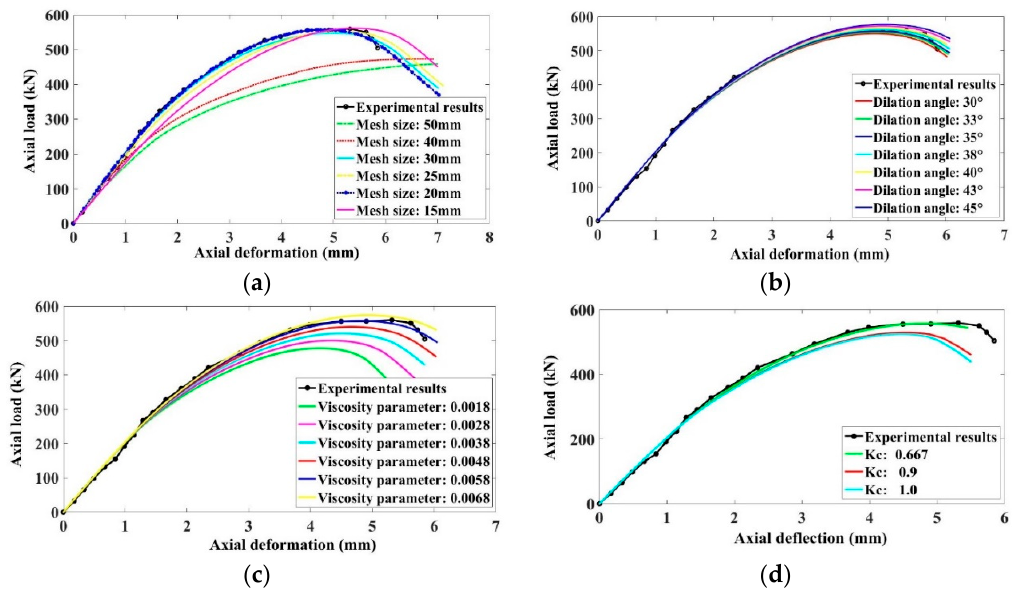
Figure 10. Sensitivity analysis of ( a ) mesh size ( b ) dilation angle ( c ) viscosity parameter ( d ) shape factor of concrete on the load-deflection curve of the control specimen.